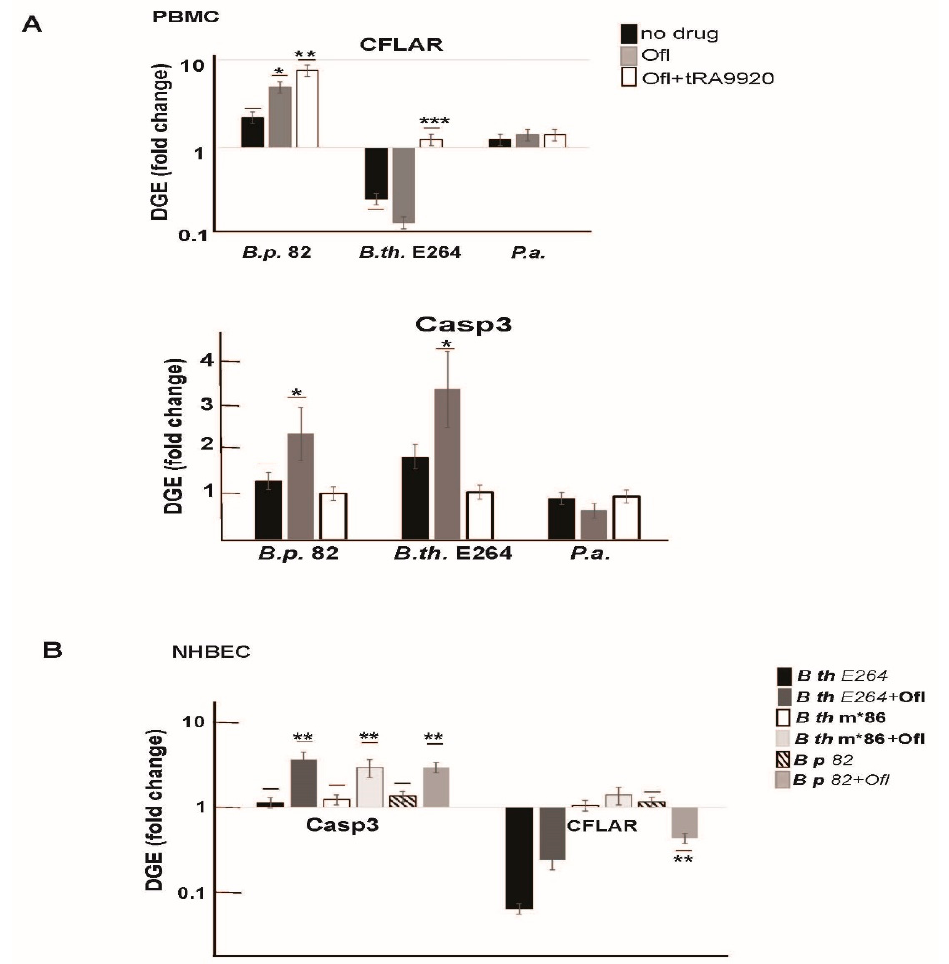
Figure 6. Antibiotic treatment exacerbates the cytotoxic effect from Burkholderia natural products and inhibition of bacterial efflux capacity with tRA99020 counteracts this effect by restoring CFLAR gene expression in host cells. ( A ) RT-qPCR analysis of cell-survival (CFLAR), and apoptosis (Casp3) regulating genes in PBMC exposed to filtered conditioned media (RPMI-10%) from untreated or antibiotic (Ofl)-treated bacterial cultures. DGE in PBMC exposed to natural products of Burkholderia pseudomallei Δ 82 (B.p. 82), B. thailandensis E264 (B.th. E264), and P. aeruginosa (P.a.), released in the media upon indicated drug treatment regiments, were calculated relative to gene transcript levels in mock-treated PBMC, including drug-free RPMI-10% and media containing Ofl or Ofl supplemented with 0.1 µM tRA99020. Data show the means and standard deviations from three independent exposure experiments using a PBMC batch from the same donor; ( B ) RT-qPCR analysis of CFLAR and Casp3 DGE in normal human bronchial epithelium cells (NHBEC) exposed to conditioned media from untreated or antibiotic (Ofl)-treated Burkholderia species. The DGE was calculated relative to gene transcript levels in mock-treated NHBEC from three independent biological experiments. GAPDH transcripts were used as an internal loading control. Unpaired Student’s t test with Sidak– Bonferroni method for multiple comparisons were applied to correct for the p values. Results were considered statistically significant at * p < 0.05, ** p < 0.01, and *** p <